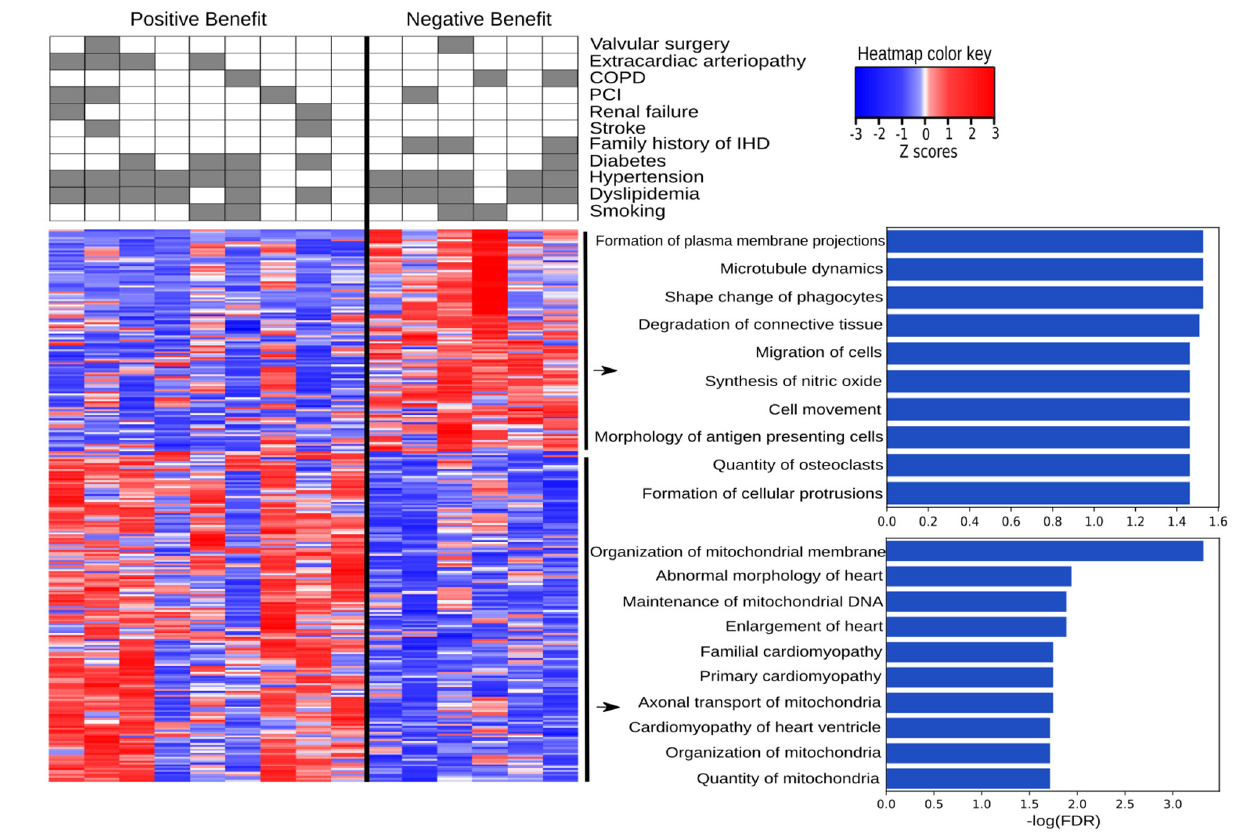
FIGURE 6 | Pathways associated with a positive and negative benefit from surgery according to EF change. The heatmap provides a visual overview of the differences between two groups in terms of DEGs and clinically associated diseases, with color key representing the Z-score, and the top ten up and down regulated pathways are listed with their log(FDR)